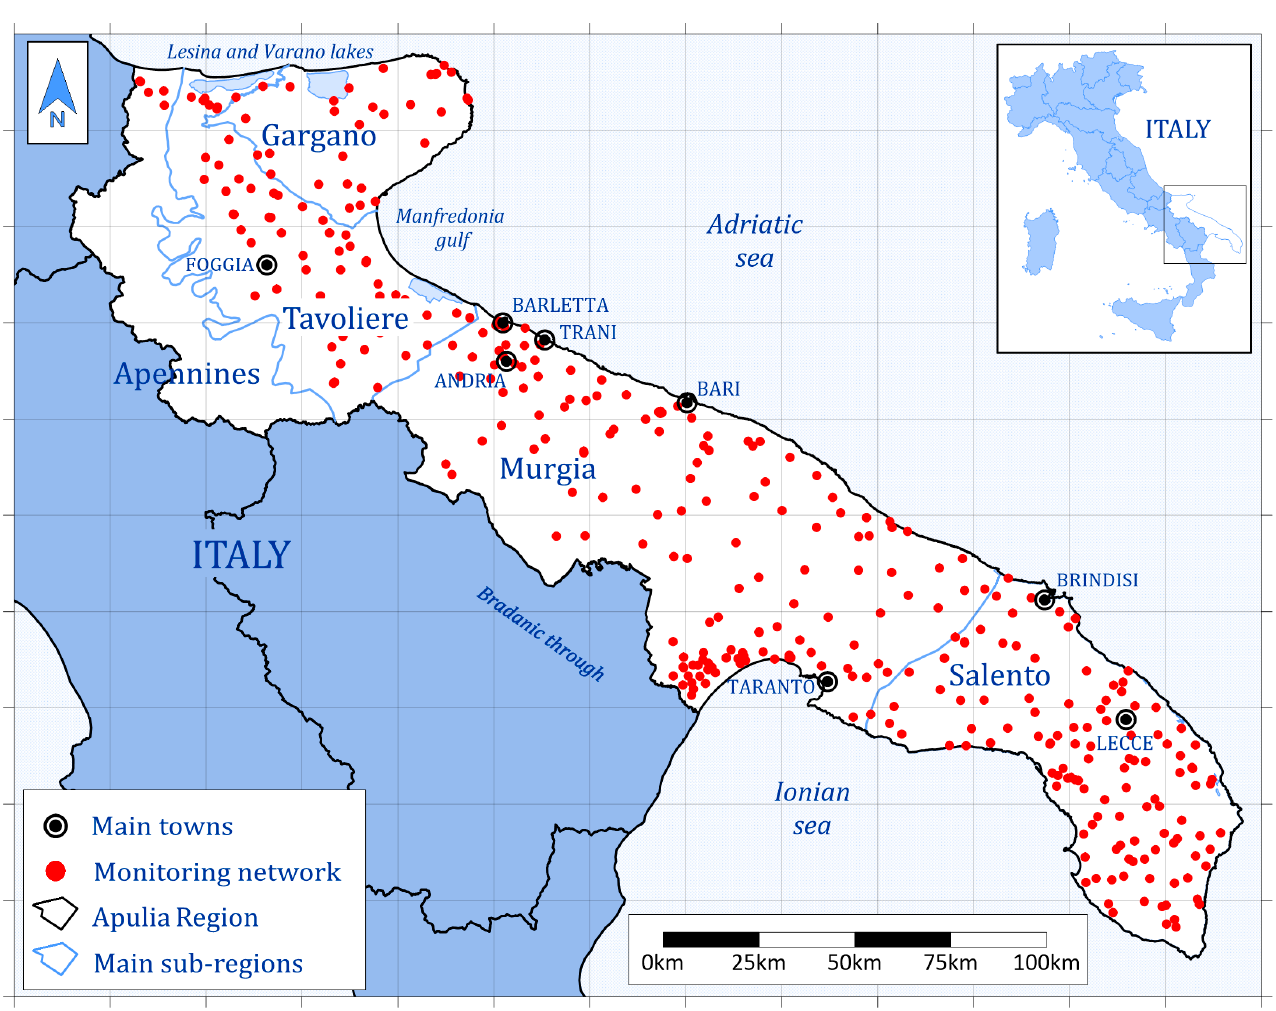
Figure 3. Map of the Apulia region, showing the main geographical sub-regional areas (Gargano, Tavoliere, Murgia and Salento) and the regional groundwater monitoring network.